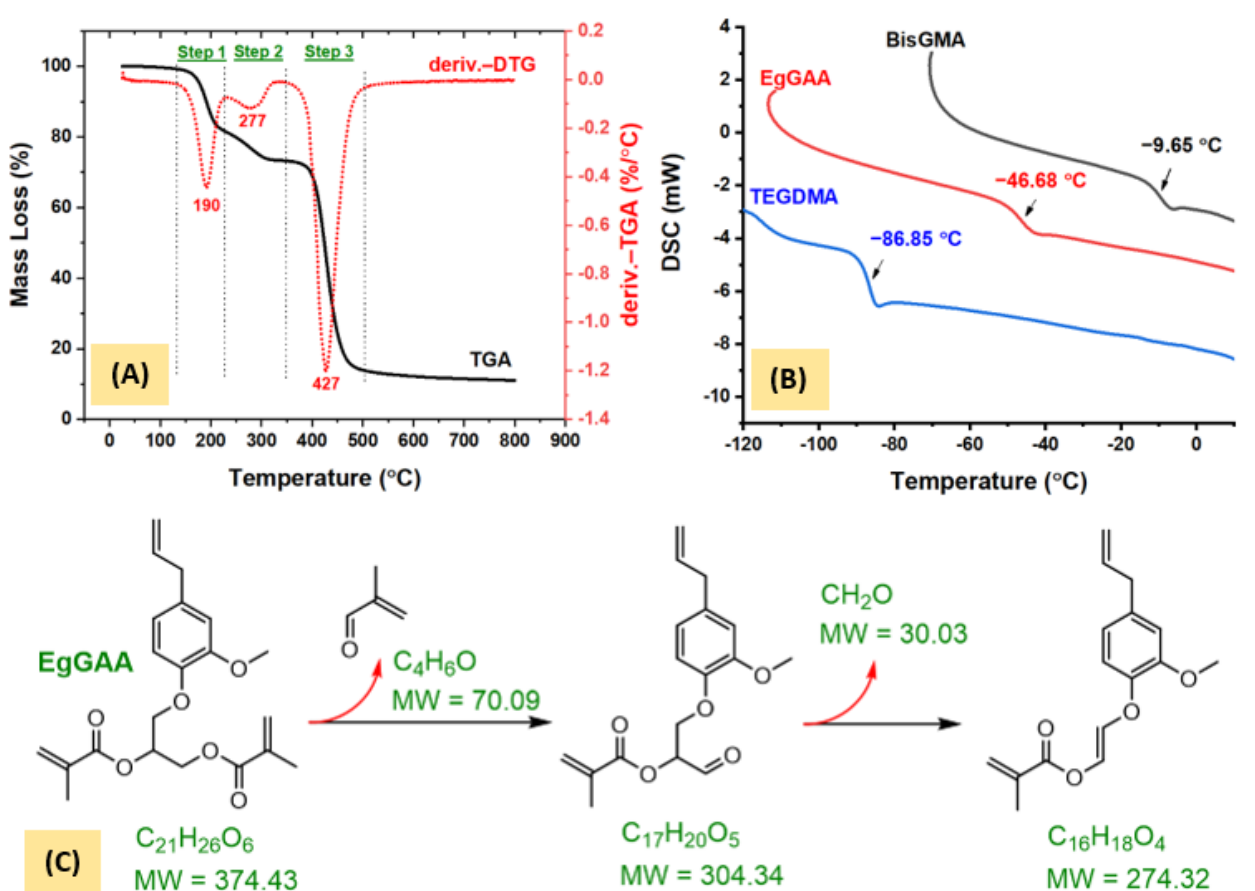
Figure 6. TGA/DTG ( A ) and DSC ( B ) curves and predicted thermal mass loss ( C ) of EgGAA monomer decomposition.